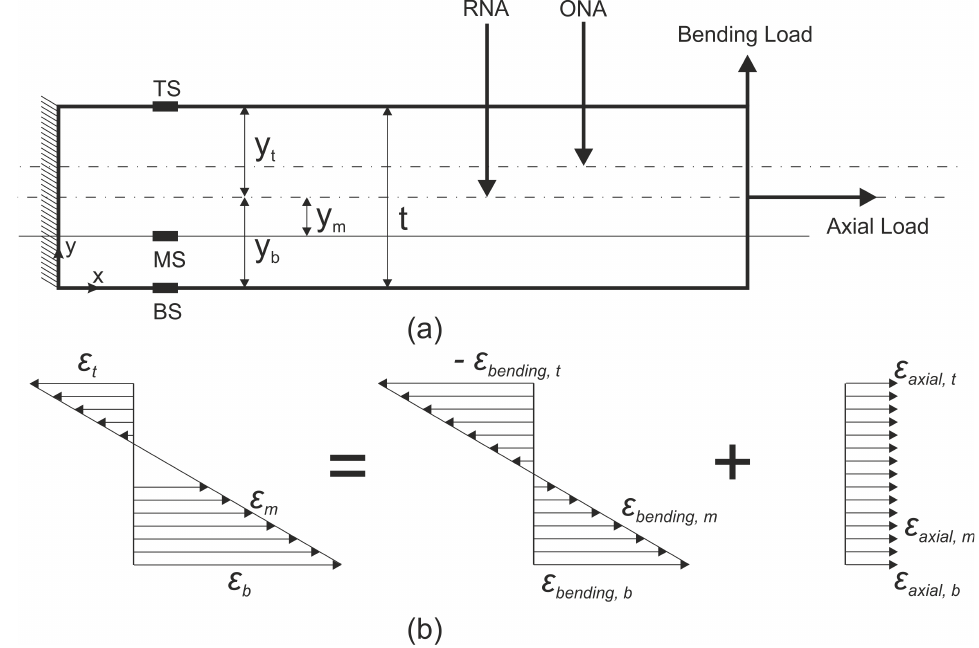
Figure 1. ( a ) Beam under axial and bending loads; and ( b ) superposition of bending and axial strains, where y t , y b and y m are distances from the real neutral axis (RNA) to the top, bottom and middle sensor, respectively, t is the sample thickness, and ONA is the observed neutral